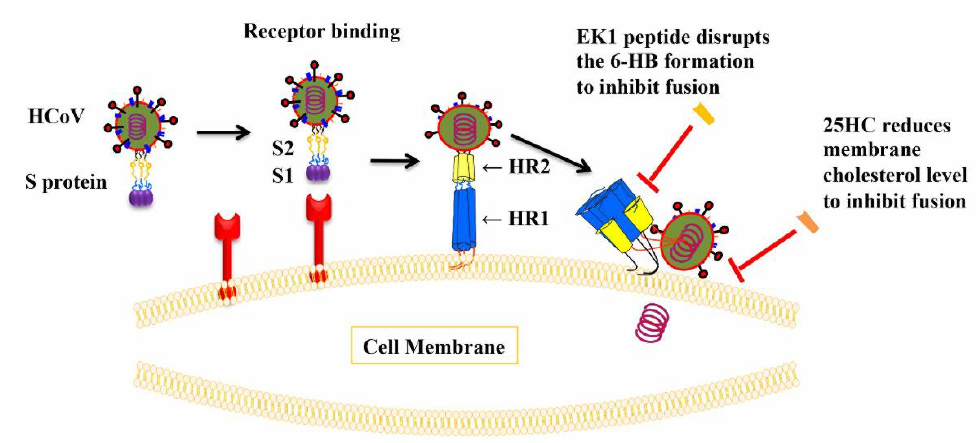
Figure 1. Entry process of HCoVs and inhibitory targets for EK1 and 25-HC. The entry process of HCoVs includes receptor binding and membrane fusion. Coronavirus spike protein is the main viral protein responsible for the entry of HCoVs and it serves as a valuable target for the development of antivirals. The receptor binding process is mainly mediated by the viral receptor-binding domain (RBD) which is located in the S1 subunit of the spike protein, while the key step of membrane fusion is mediated by the formation of 6-HB structure (interaction of HR1 and HR2 domains). EK1 peptide targeting the HR1 domain can disrupt viral 6-HB formation to inhibit membrane fusion, and 25-HC reduces membrane cholesterol to inhibit membrane fusion, thus indicating distinctly different mechanisms of action.